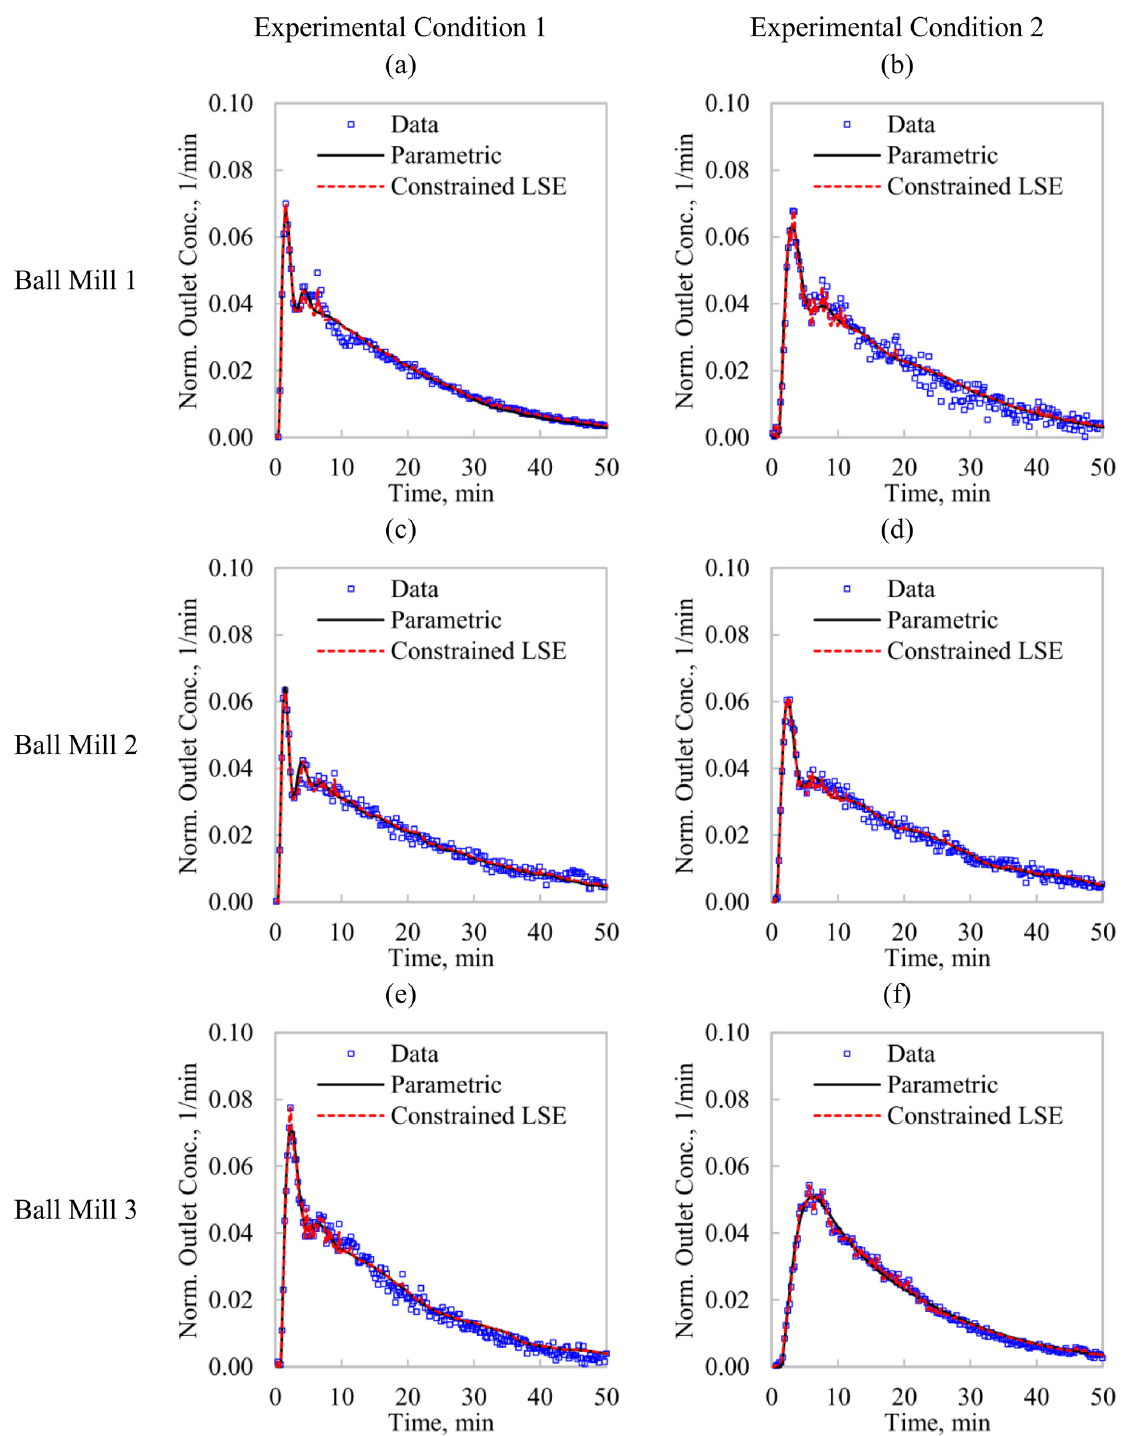
Figure 3. Model fitting represented as outlet signal reconstructions (solid tracer) from the constrained LSE and parametric approaches: Ball Mill 1 ( a ) Experimental Condition 1, ( b ) Experimental Condition 2; Ball Mill 2 ( c ) Experimental Condition 1, ( d ) Experimental Condition 2; Ball Mill 3 ( e ) Experimental Condition 1, ( f ) Experimental Condition 2.